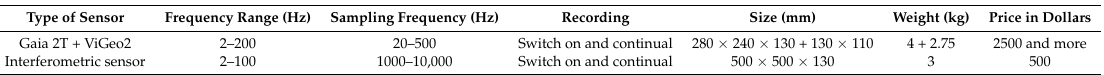
Table 1. A comparison of the basic parameters of the proposed interferometric sensor and used seismic